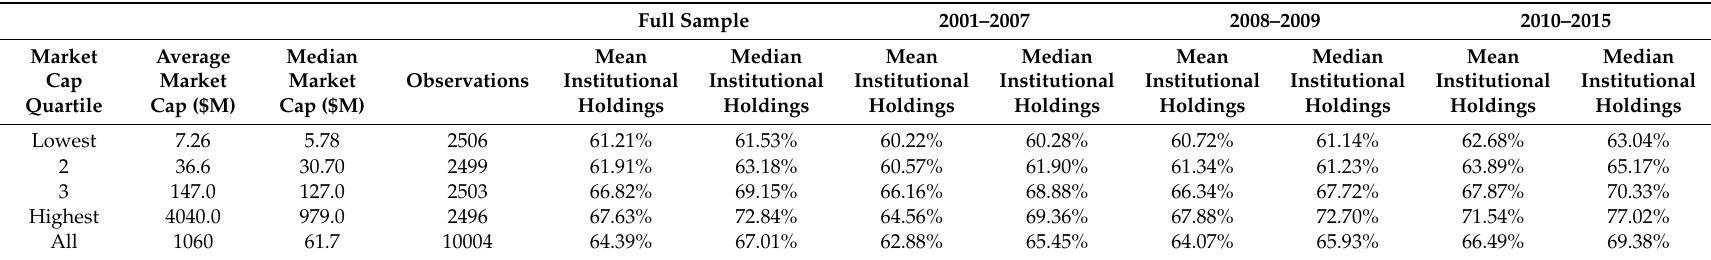
Table 1. Institutional Ownership—Summary Statistics . This table reports aggregate institutional shareholdings across four market capitalization quartiles for the full sample and three sub-sample periods. Institutional ownership is the percentage of shares owned by the top 20 shareholders. The sample includes 1140 Australian listed firms and 10,004 firm-year observations for the period between 2001and 2015. We obtain the data from Securities Industry Research Centre of Asia-Pacific (SIRCA) and Data Analysis Premium respectively. We do not include financial companies and utility companies in the sample.